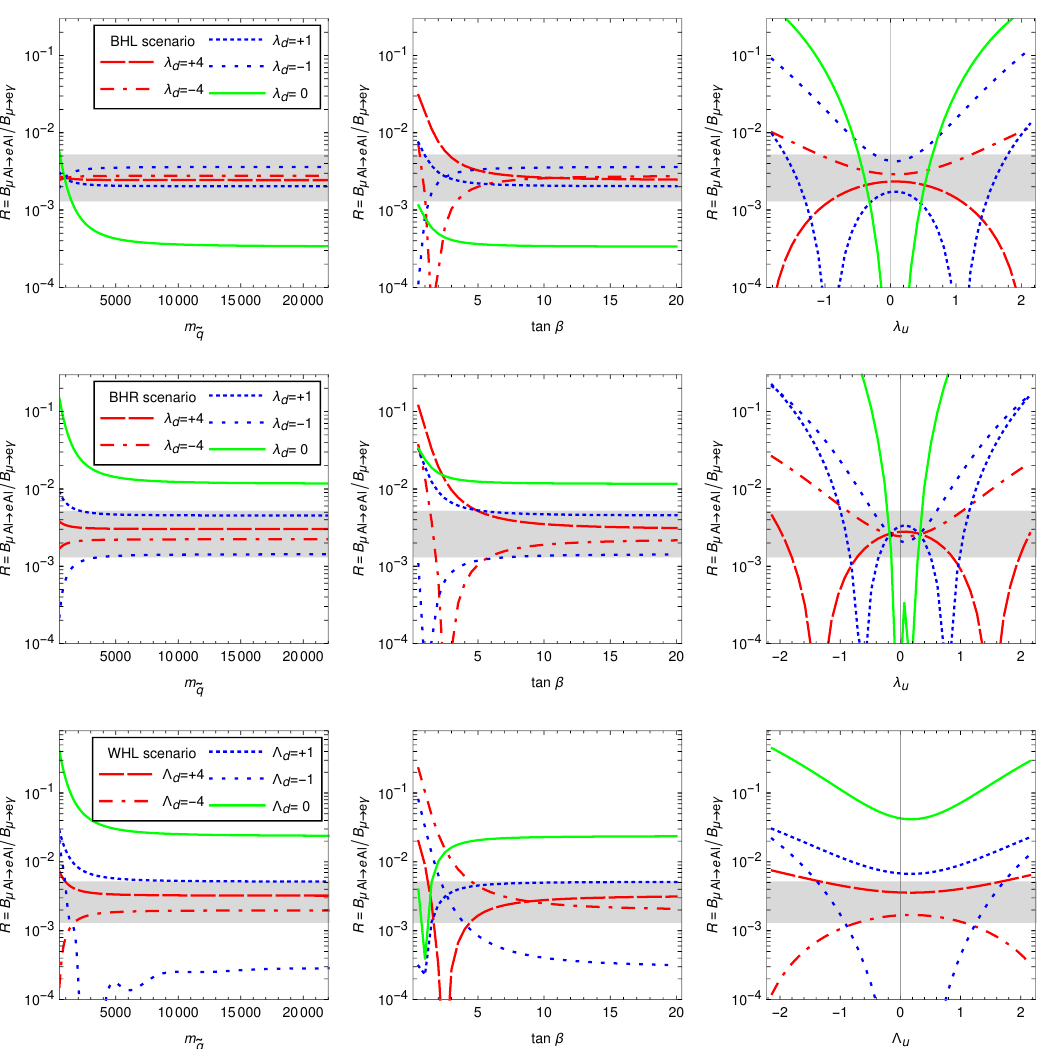
Figure 10. The ratio R (Al) of the (cid:22) e and (cid:22) e(cid:13) branching ratios as function of the ! ! squark mass, tan (cid:12) , and of (cid:21) u or (cid:3) u , as appropriate. The plots in the (cid:12)rst, second, and third rows correspond to the BHL, BHR, WHL scenarios, respectively; the legends correspond to all plots in each row. In each plot all parameters are (cid:12)xed to the standard values for each scenario with m SUSY = 500 GeV except in the (cid:21) u , (cid:3) u plots, where (cid:22) u = m SUSY . The gray band indicates the expectation corresponding to dipole dominance, eq. (4.27), allowing a (cid:13)uctuation by a factor 2 up or down.